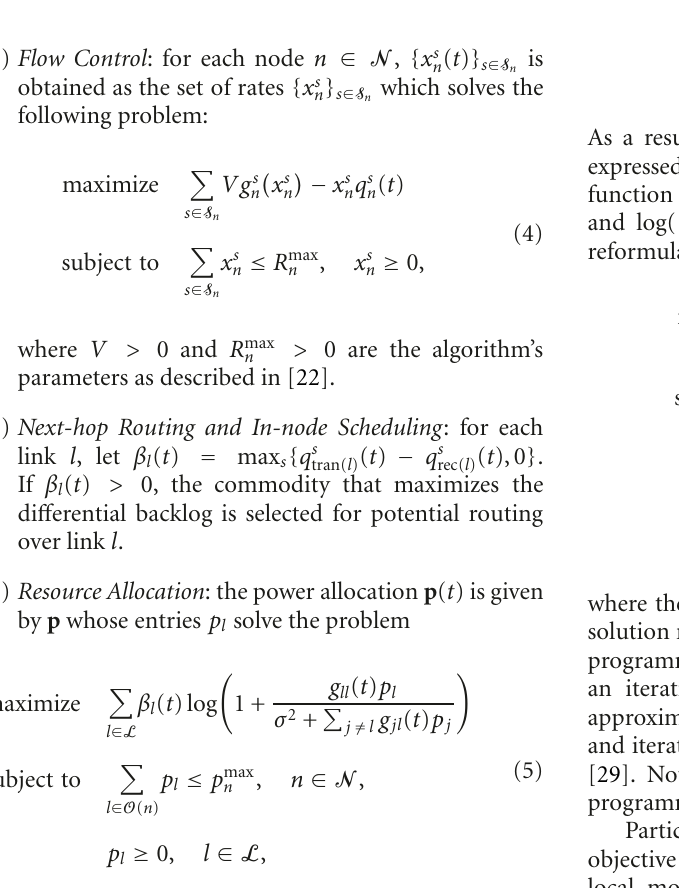
Algorithm 1 (Dynamic Cross-Layer Control Algorithm [22]).